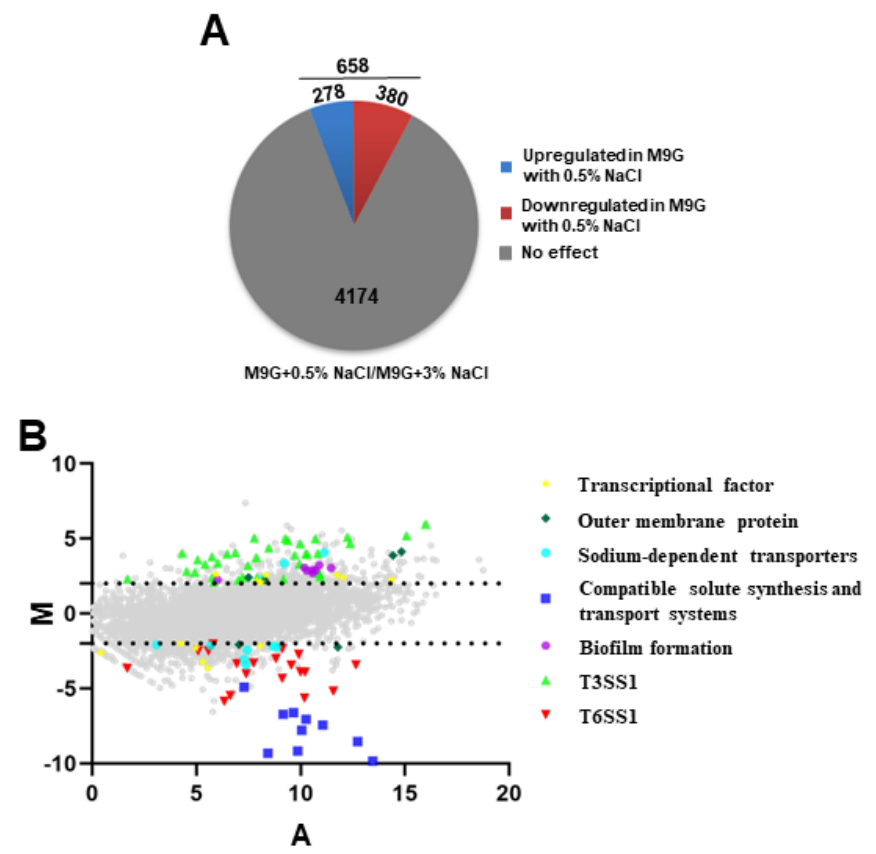
Figure 2. The effects of 0.5% NaCl on V. parahaemolyticus gene expression. ( A ) Pie charts show the differentially expressed genes under 0.5% NaCl in an M9 medium; ( B ) MA plots indicating the changes that were observed in gene expression at 0.5% NaCl compared to WT cultured in 3% NaCl. The genes associated with regulators, osmotic stress, and virulence are highlighted. X-axis means the average log2 value for transcript abundance under both conditions; Y-axis means the log2 values for the ratios of abundance for each transcript shown between WT cultured under 0.5% and 3% NaCl.